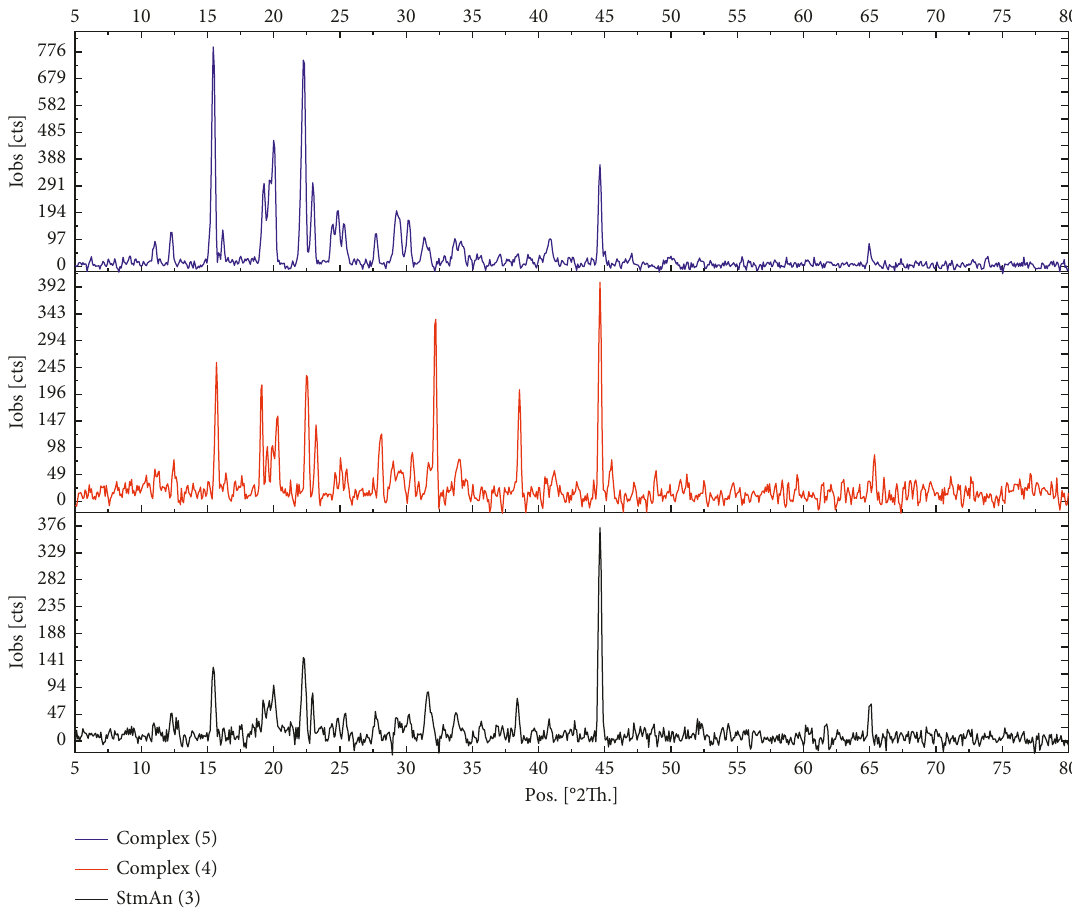
Figure 4: Powder XRD pattern of the ligand and metal